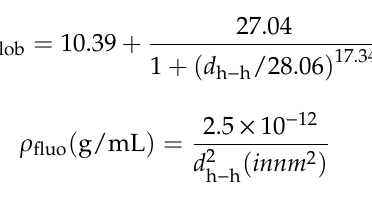
Figure 5. Fluorescence decays of the pyrene ( A ) monomer and ( B ) excimer of Py(4.8)-NAF57 in DMSO with 0.32 g/mL PEG(5.0K). ( C ) Plot of ( , right axis) N blob , ( ) PEG(5.0K) concentration, and ( ) ρ fluo as a function of PEG(5.0K) wt%. [Py(4.8)-NAF57] = 9.1 mg/L. The concentration of PEG(5.0K) in these DMSO solutions was determined by multiplying the density of the PEO(5.0K) solutions in DMSO given by Equation (1) with the weight fraction of the